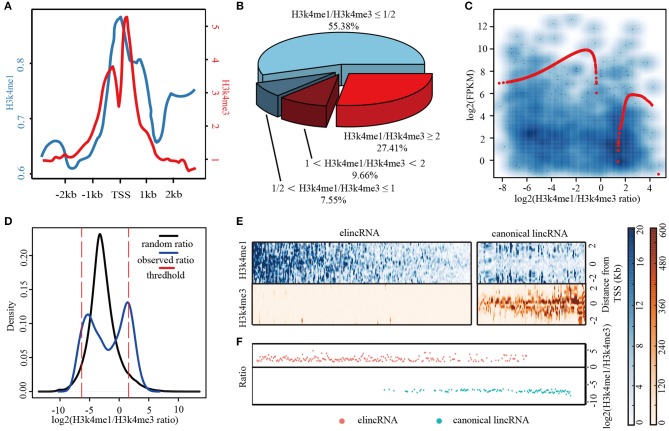
Identification of elincRNAs and canonical lincRNAs with high confidence. (A) Density plots showing the distributions of H3K4me1 and H3K4me3 in known lincRNA TSS intervals. (B) Analysis of the H3K4me1/H3K4me3 ratio and the corresponding lincRNAs (C) Correlation analysis of the H3K4me1/H3K4me3 ratio and expression levels of the corresponding lincRNAs. (D) The identification of elincRNAs and canonical lincRNAs. (E) Heatmap showing the distributions of H3K4me1 and H3K4me3 in TSS intervals of identified elincRNAs and canonical lincRNAs. (F) Dots plots showing the log2 (H3K4me1/H3K4me3) ratio in TSS intervals of identified elincRNAs and canonical lincRNAs.